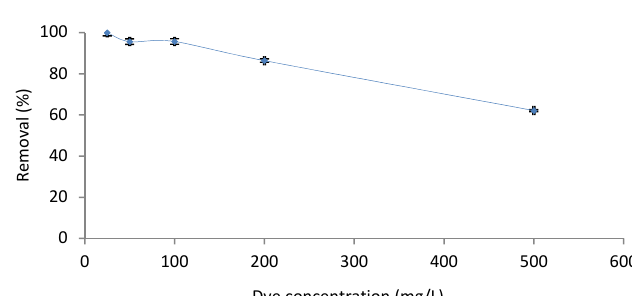
Fig. 2: Effect of dye concentration on the removal percentage